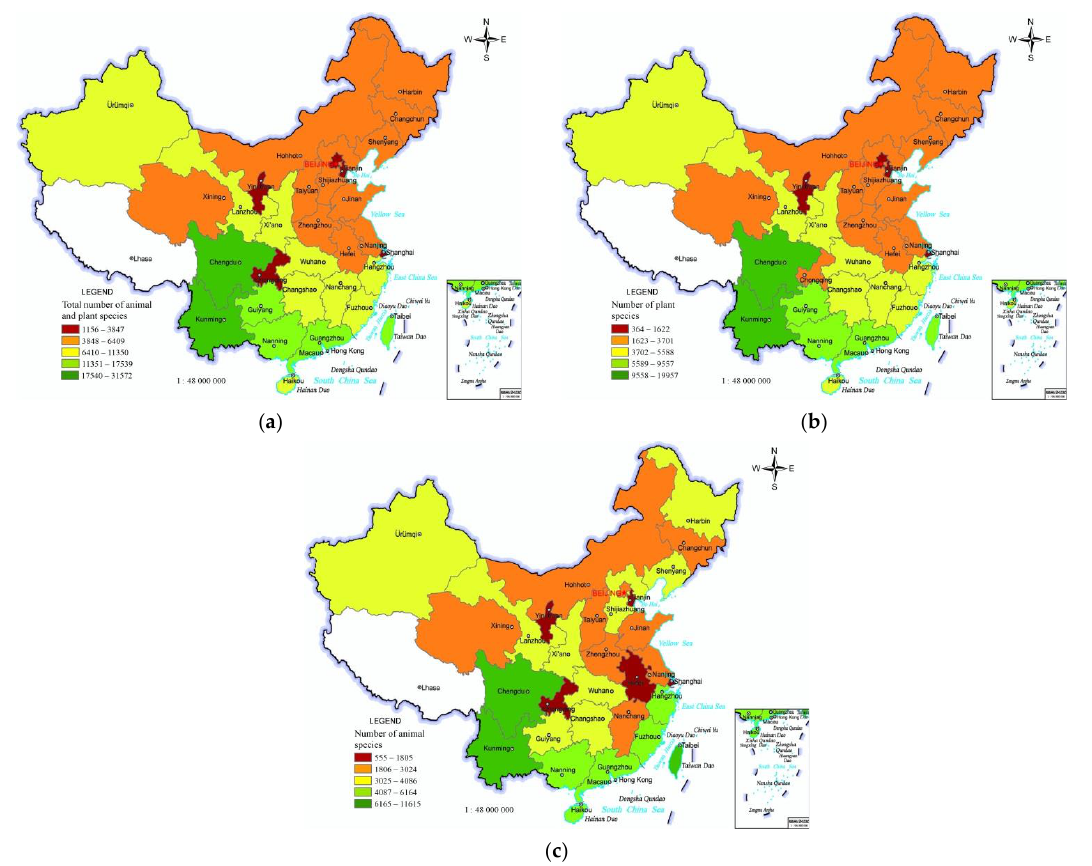
Figure 5. The numbers of species of animals and plants, plants, and animals in the PARs of China. ( a ) Total number of animal and plant species. ( b ) Number of plant species. ( c ) Number of animal species.